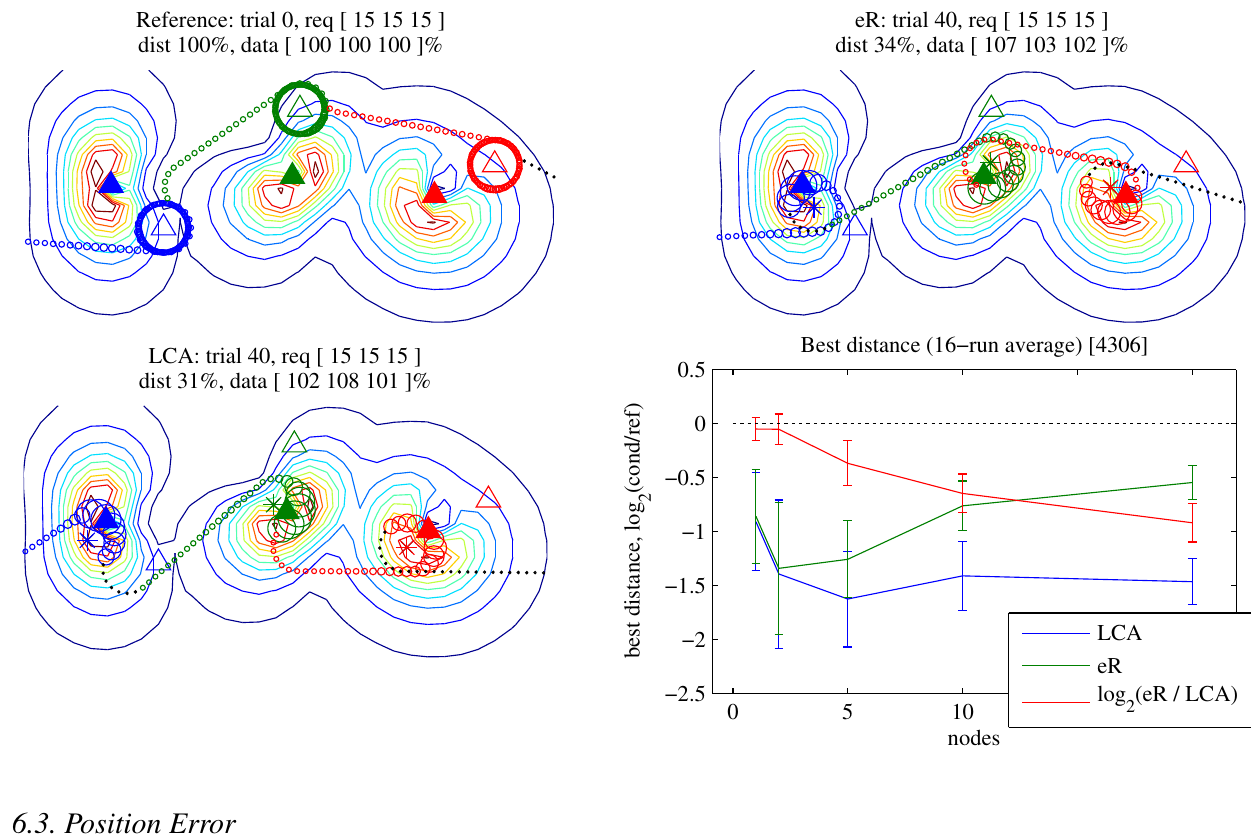
Figure 7. Data-loops trajectories with and without “LCA-length” after 40 trials as the number of nodes increases. The sensor position knowledge error here is 8 and α = 1 , to show learning speed. As expected, for small numbers of nodes LCA does not help much, but as the number of nodes grows eR’s learning speed (reflected by the solution quality after 40 trials) deteriorates whereas with LCA it does